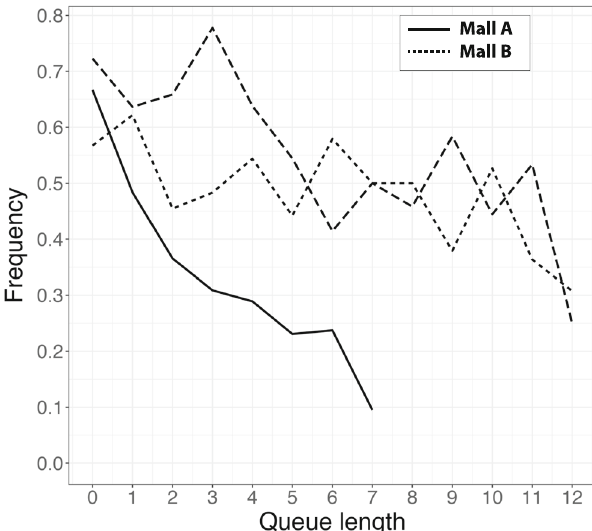
Fig. 8 Fraction of freight vehicles choosing to join the queue vs. the length of the queue. We observe one day at mall A and two days at mall